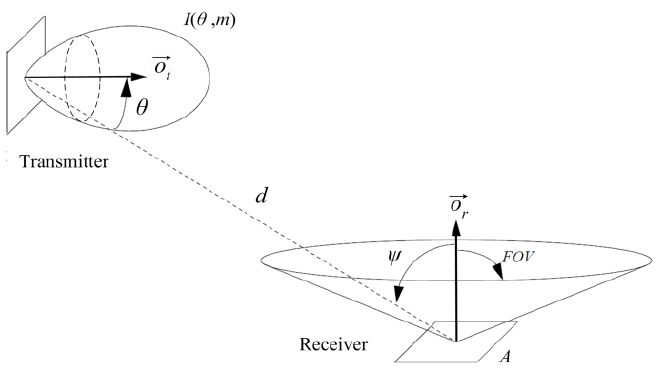
Figure 2. Transmitter and receiver in directed LOS link